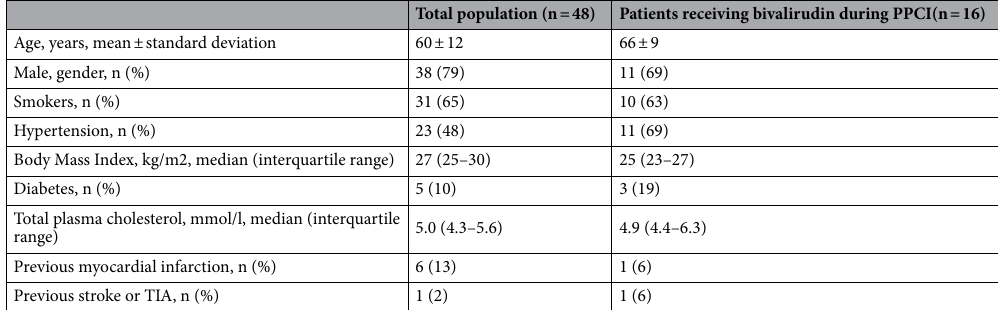
Table 1. Baseline characteristics of the study population. More details have been provided by Funck-Jensen et al. 6 . PPCI = primary percutaneous coronary intervention; TIA = Transient ischaemic